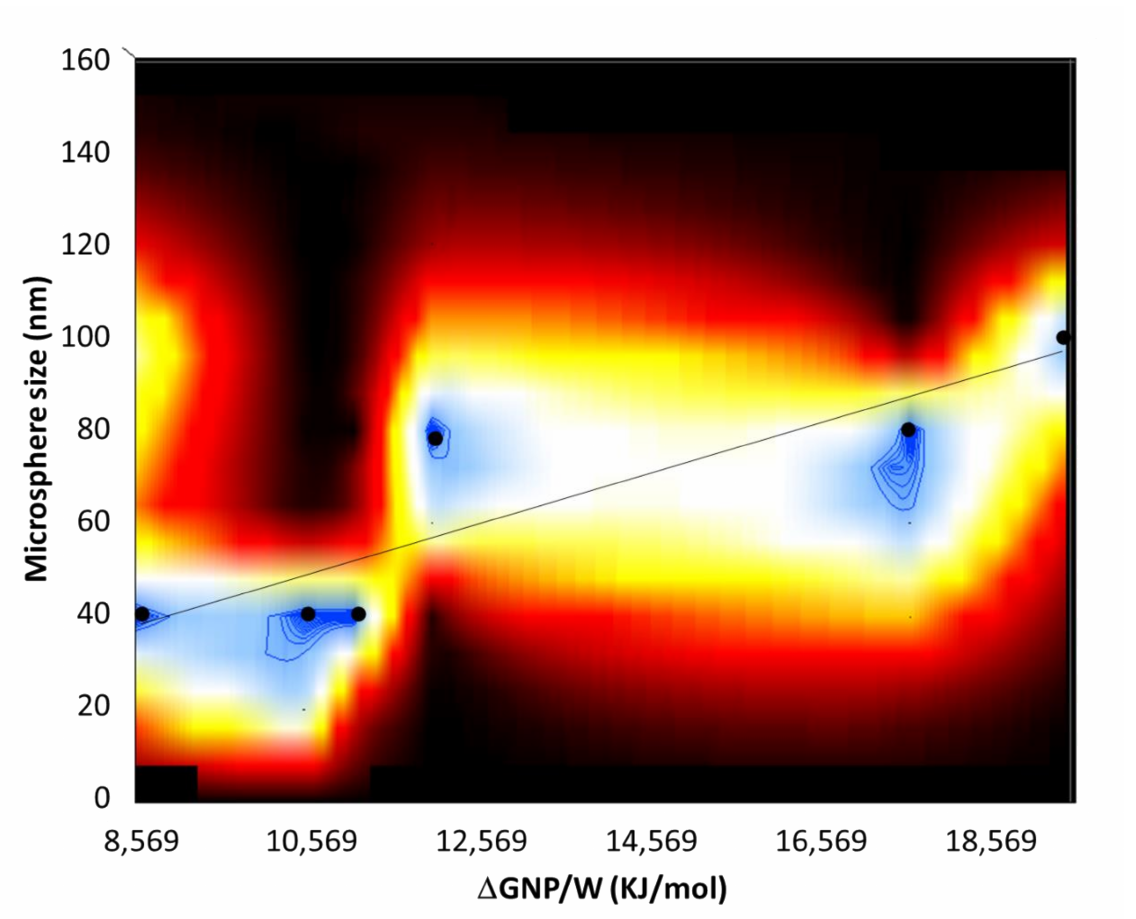
Figure 7. 2D surface plot relating the normalized population distribution of the microspheres ( z -axis) as a function of energy of detachment ∆ G NP/P of the NPs ( x -axis) and the size of the microspheres ( y -axis). The filled circles represent the data points corresponding to the maximum of the size distribution of the microspheres, and the black line is a guide to the